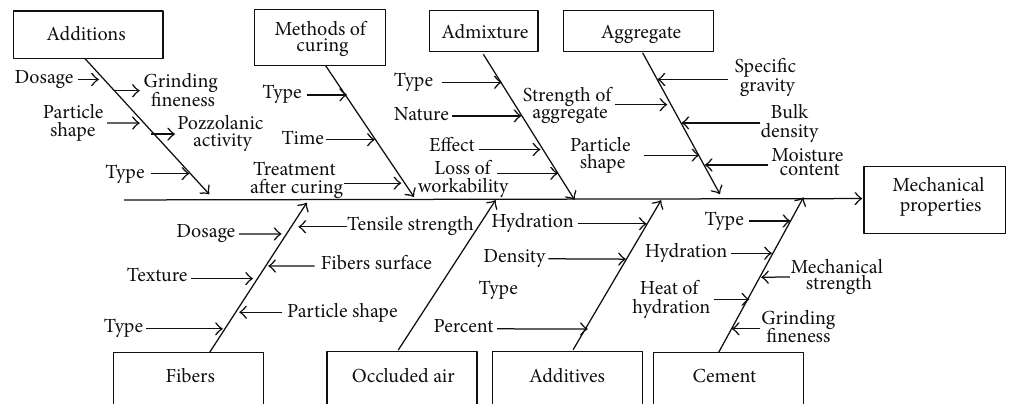
Figure 2: Fishbone diagram of factors affecting the mechanical properties of concrete.